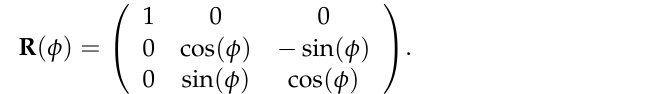
I B and the body fixed frame . { } − { }